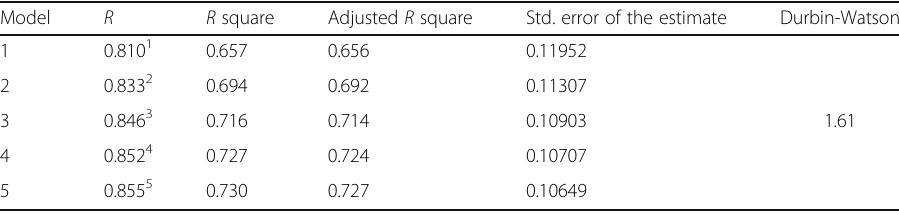
Table 3 Summary of factors influencing the consumers ’ perception of the environmental effects of organic agriculture based on Stepwise Multiple Linear Regression